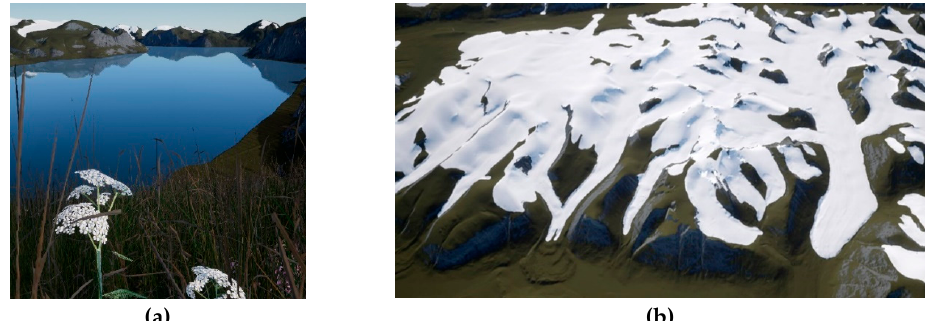
Figure 9. Landscape scenery in UE4 with natural terrestrial coloration. Even distant landscape parts are visible.